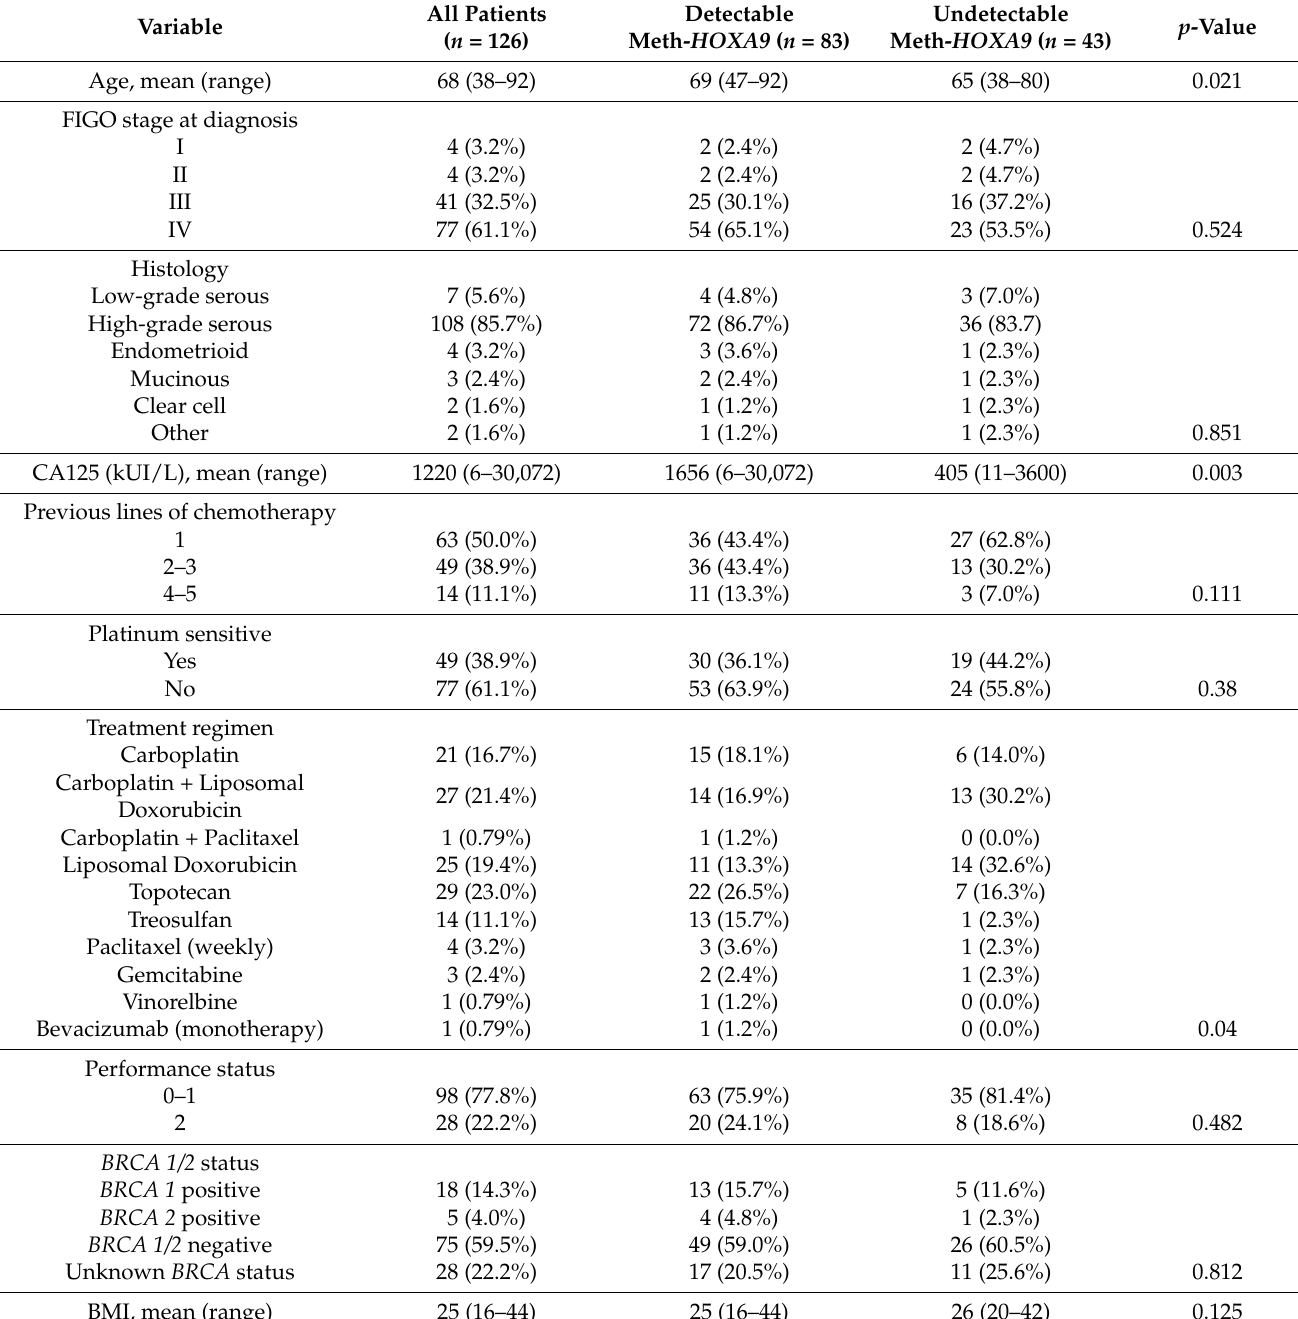
Table 1. Patient characteristics and status of meth- HOXA9 at